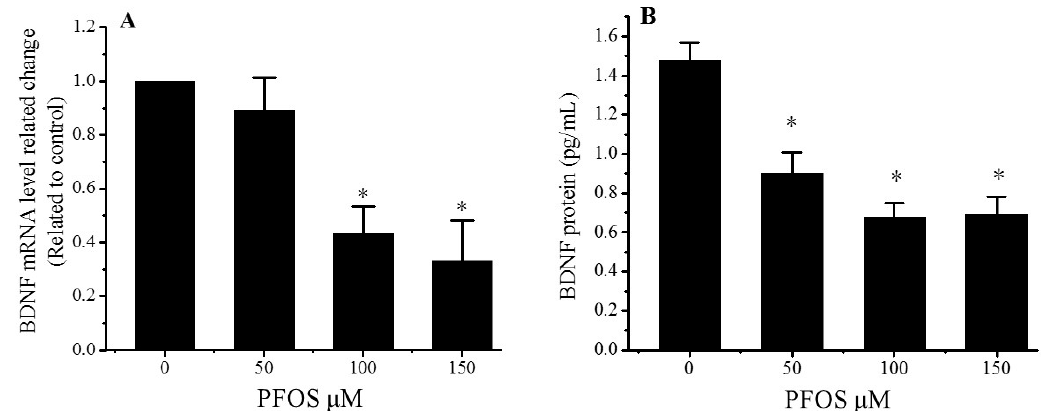
Figure 3. Effects of PFOS on the expression of brain-derived neurotrophic factor (BDNF), in SK-N-SH cells. ( A ) BDNF mRNA levels in SH-SY5Y cells. Each data point was normalized to the control (DMSO). ( B ) BDNF protein levels in SH-SY5Y cells. The data are presented as mean ± SD from three independent experiments. * Compared with control: p < 0.05.